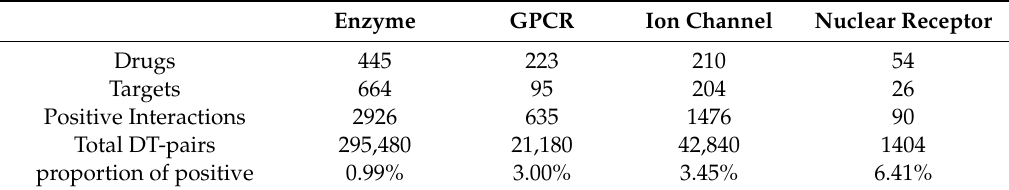
Table 5. Statistics of gold standard